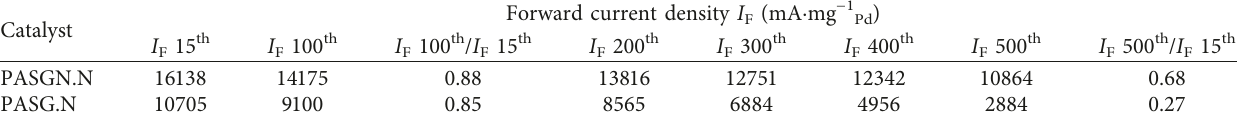
Table 4: Forward current density of PASGN.N and PASG.N catalysts after 500 scanning cycles in a (NaOH 0.5M+C at a scan rate of 50 mV · s − 1 . Catalyst